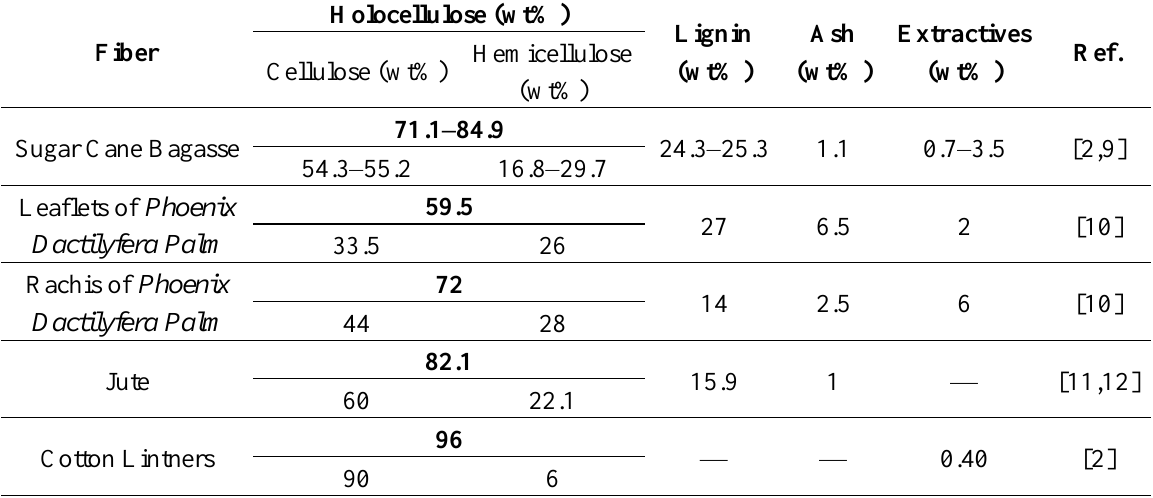
Table 2. Chemical composition of some lignocellulosic